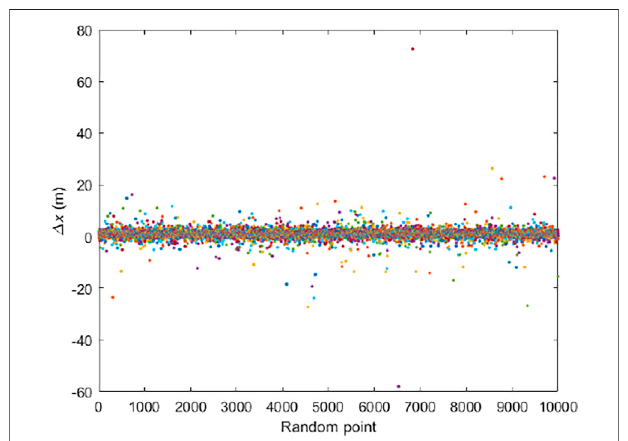
FIGURE 4 | Regulation effect of Δ f on the location